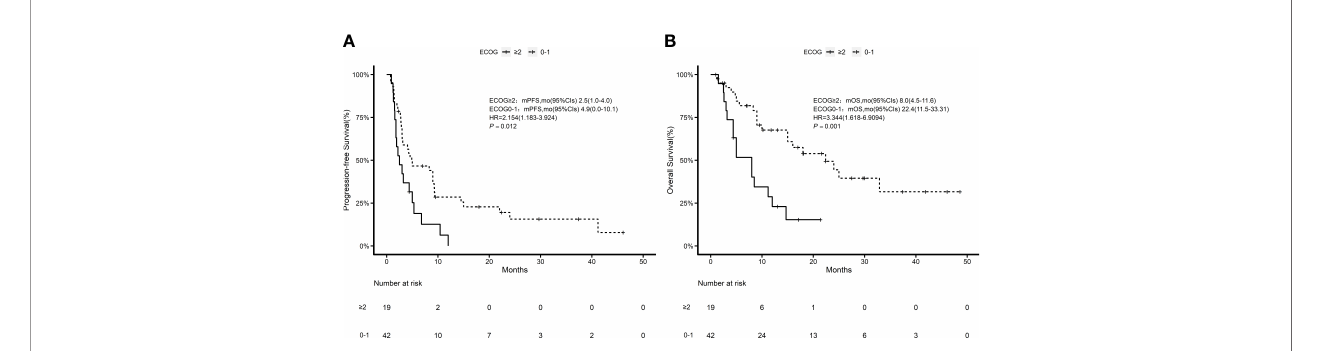
FIGURE 3 | Kaplan – Meier estimates of ECOG 0 – 1 and ECOG ≥ 2 patients. (A) Kaplan – Meier estimates of progression-free survival; (B) Kaplan – Meier estimates of overall survival.